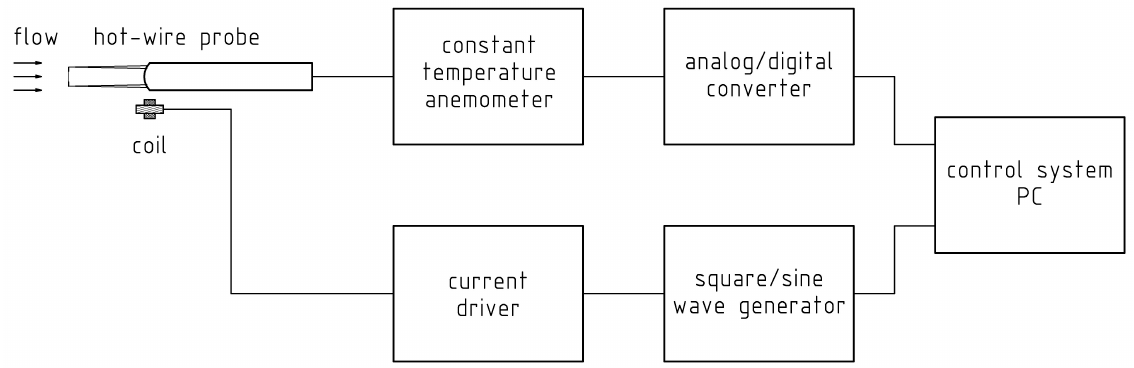
Figure 1. Schematic of a modified system for determining the frequency bandwidth of a constant-temperature anemometer.